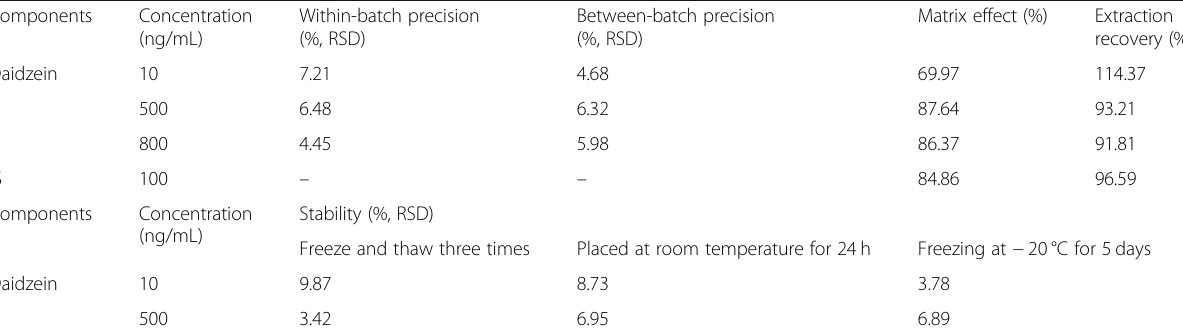
Table 2 Precision, matrix effect, extraction recovery and stability of daidzein, and IS detected by LC – MS/MS method ( n = 6) Components